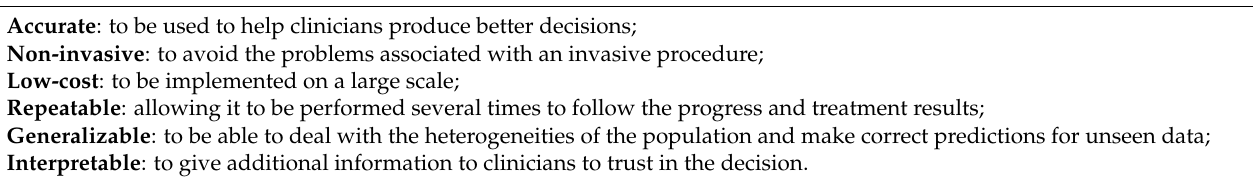
Box 1. Key features of CADs for lung cancer diagnosis.